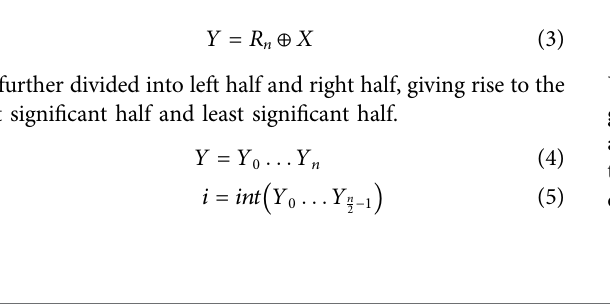
Frontiers in Blockchain |